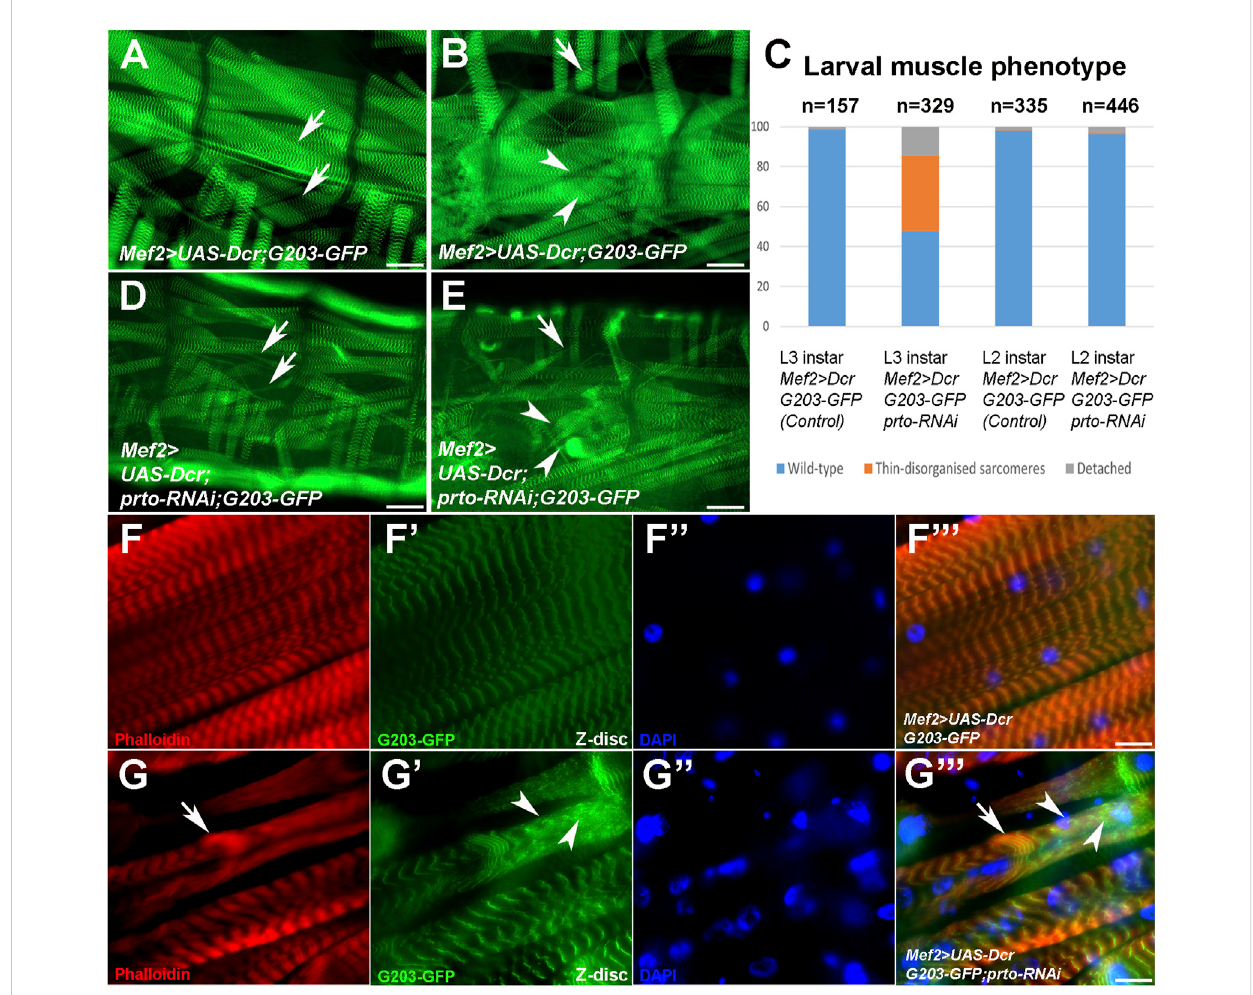
FIGURE 3 prto is required to maintain sarcomeric homeostasis. (A – F) Whole mount of L3 larvae muscle preparations expressing a GFP trapped Z-disc protein (203-GFP) in control (A,B) and Mef2 > UAS-Dcr;prtoRNAi (D,E) larvae raised at 29 ° C and muscle phenotypic analysis of L2 and L3 somatic muscles (C) . Scale bar 50 µm. Arrows denote wild-type and over-stretched muscles and arrowheads wild-type and muscle detachments. Note in (C) ~ 50% somatic muscles are thinned or truncated in prto de fi cient muscles in comparison to control. No phenotypic differences are observed in L2 instar. (F – F - ) SarcomericarchitectureofL3controlsomaticmuscledisplayingactin fi laments(phalloidin; (F) ),Z-disks(203-GFP; (F 9 ) ),nuclei(DAPI; (F 99 ) )andmerge (F - ) . Scale bar 20 µm. (G – G - ) Sarcomeric structure in Mef2 > UAS-Dcr;prto-RNAi L3 muscles show a loss of the repeated sarcomeres with clumps of actin fi laments ( (G) , arrow), clusters of sarcomeric proteins distributed in the sarcolemma ( (G 9 ) , arrowheads) and nuclei being abnormal in shape and non- evenly distributed along the muscle (G 99 ) and merge (G - ) . Scale bar 20 µm.